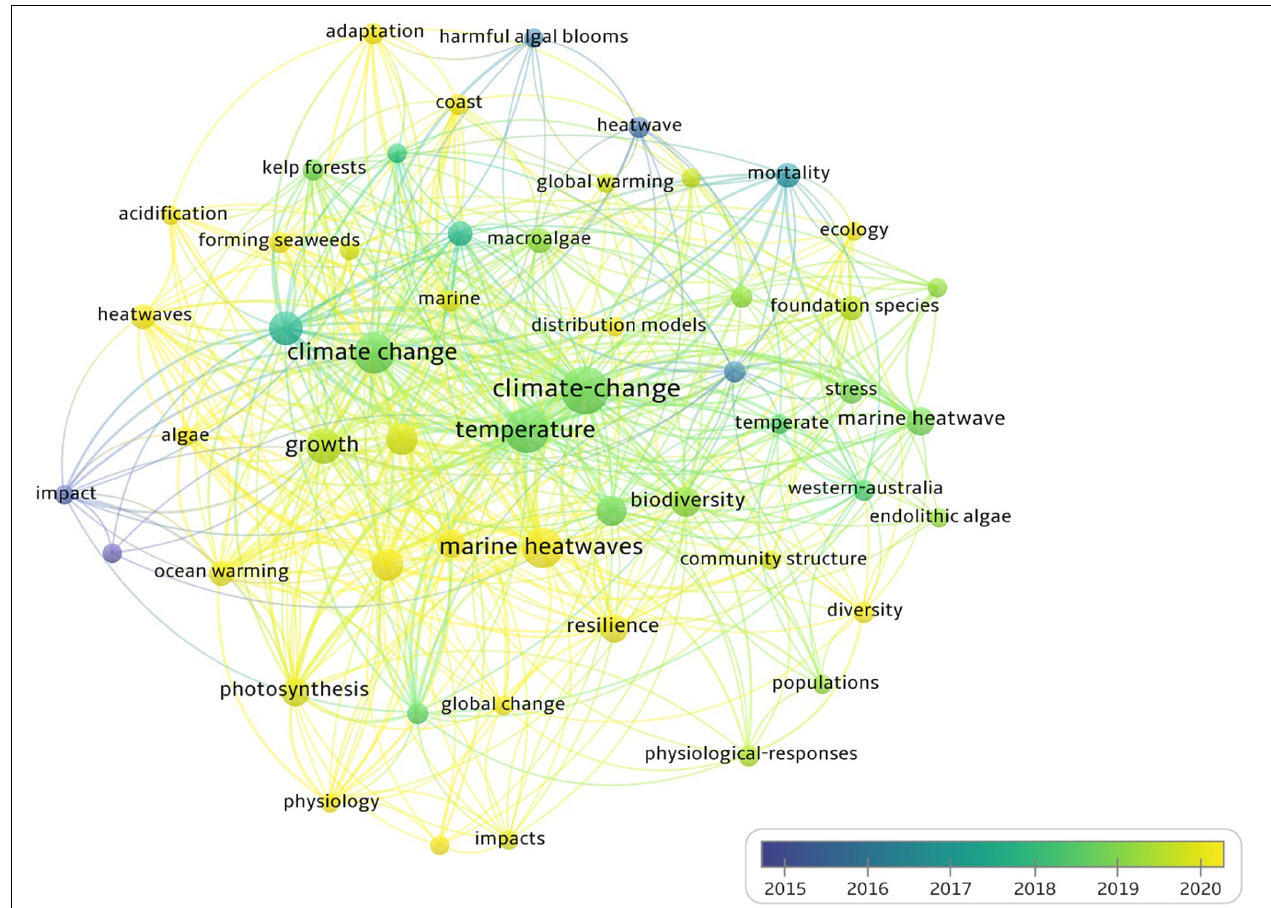
FIGURE 1 | Bibliometric map of the studies of the impacts of MHWs on algae based on co-occurrence of keywords. The size of the dot is proportional to the frequency that a certain keyword appears in the analyzed articles. The line between two dots means that these two keywords appeared in the same article. The thicker the line, the more frequently the two keywords appeared in the same articles. The color represents the year when a certain keyword most frequently appeared in